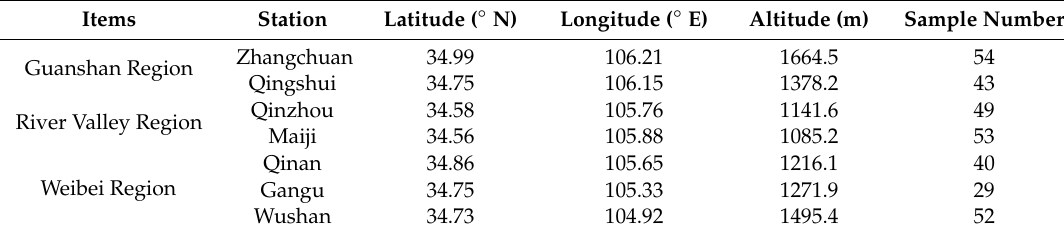
Table 1. Sampling stations in study